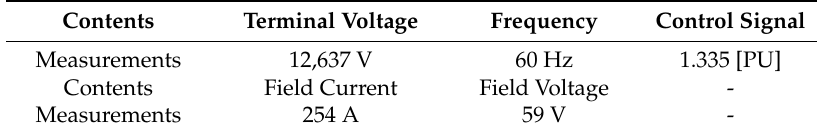
Figure 17. The initial waveform of terminal voltage in manual mode (No-load state). Table 3. The specification of a gas turbine at the thermal power plant (2).